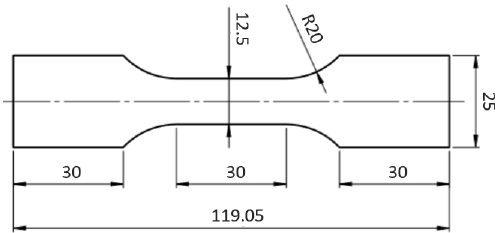
Figure 2. Dimensions of the sample used for tensile tests.